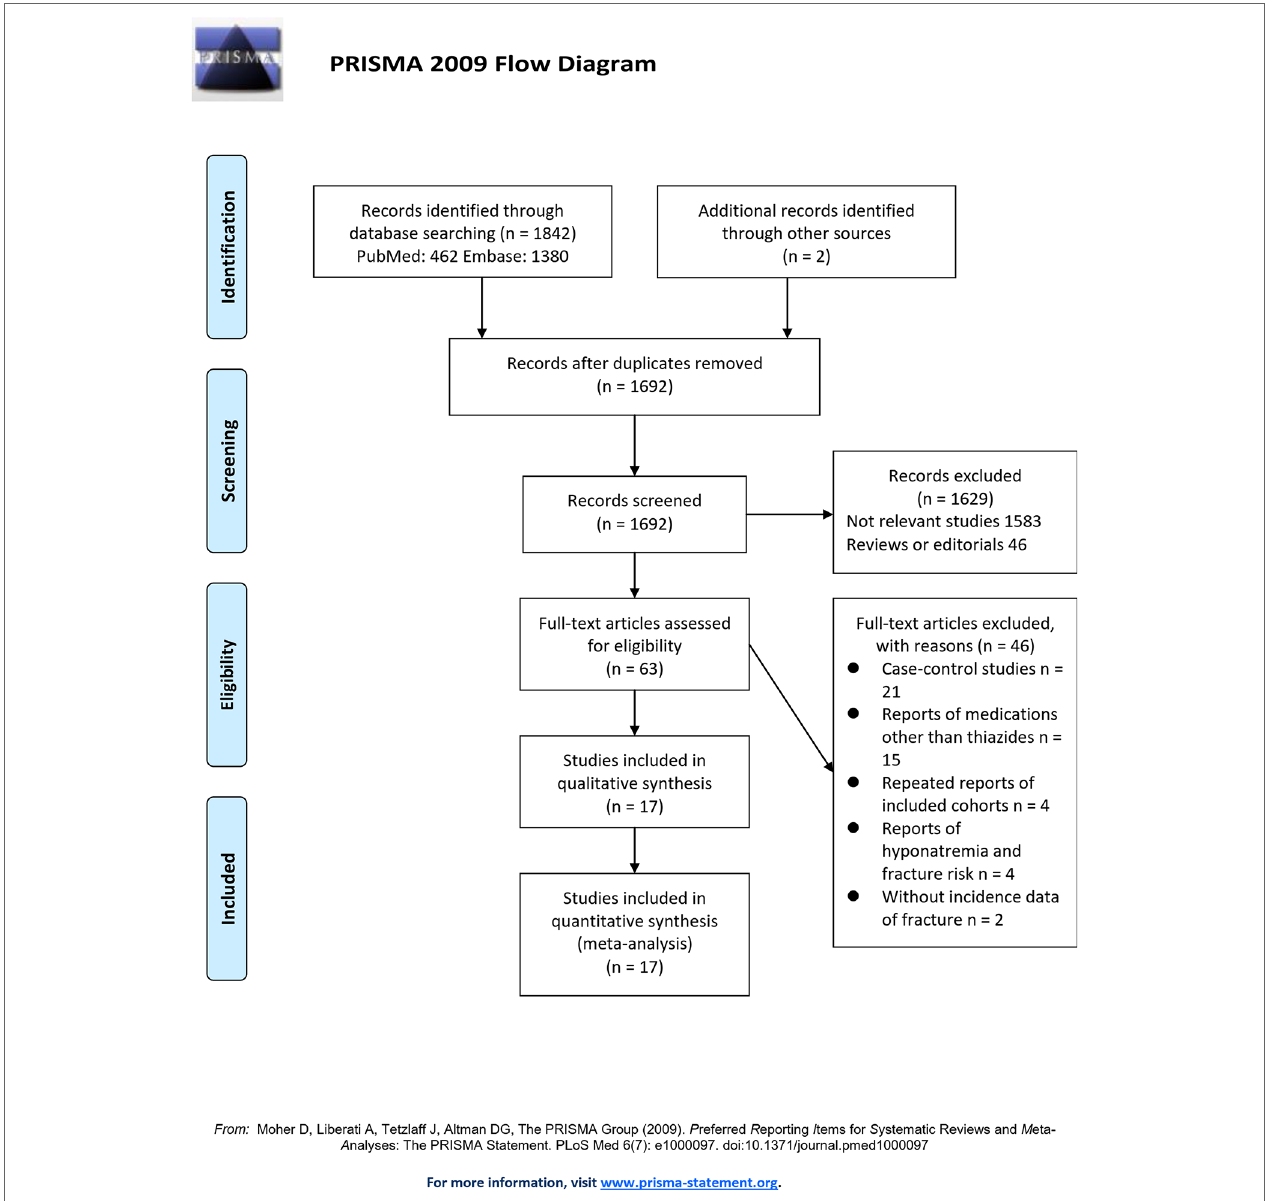
FIGURe 1 | Flowchart of database search and study